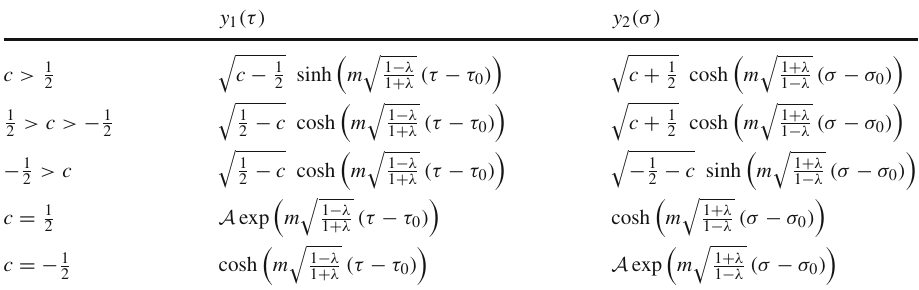
Table 1 First class of solution for the SL ( 2 , R )/ U ( 1 ) V λ -deformed